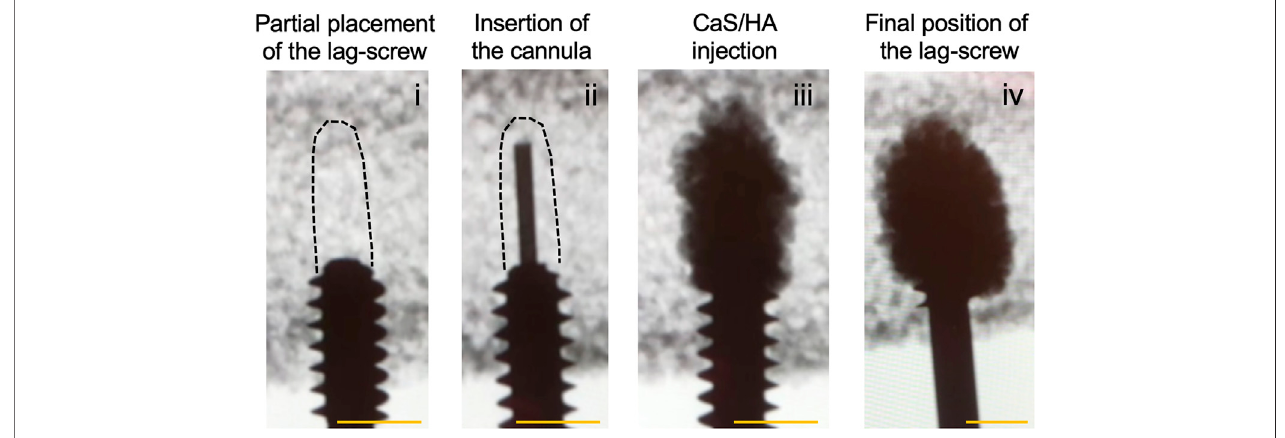
FIGURE 1 | CaS/HA biomaterial-based augmentation of a lag-screw in an osteoporotic Sawbones model. An overview of experimental steps is provided in the radiological time-lapse images startingfrom (i)the partial placementof the lag-screw followed by(ii) insertion ofthe injection device through the lag-screw (ii).(iii) CaS/HA biomaterial fi lled in the pre-drilled canal and (iv) the fi nal position of the lag-screw surrounded by the CaS/HA material. Dashed black lines in (i) and (ii) indicate the approximate position of the pre-drilled region. Scale bar = approximately 1.3